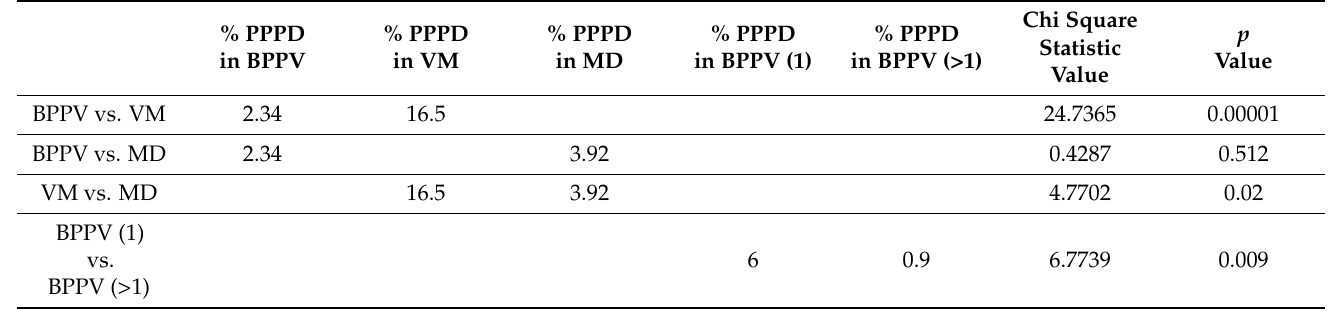
Table 4. Incidence (%) of the Persistent Postural Perceptual Dizziness in the episodic vestibular disorders considered as precipitating conditions. Statistical evaluation and comparison between the groups. Persistent Postural Perceptual Dizziness: PPPD. Benign Paroxysmal Positional Vertigo: BPPV. Single (or first) episode of Benign Paroxysmal Positional Vertigo: BPPV (1). More than one episode (or not the first) of Benign Paroxysmal Positional Vertigo: BPPV (>1). Vestibular Migraine: VM. Meniere Disease: